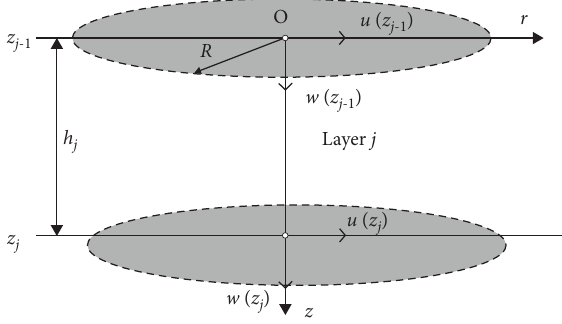
Figure 2: Te homogeneous single-layered